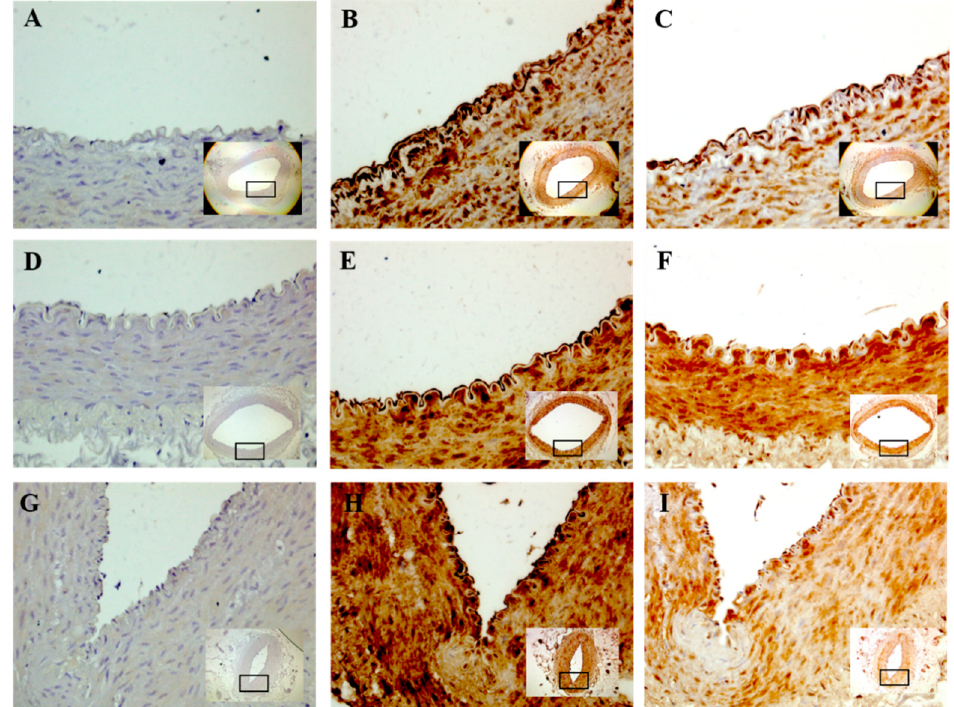
Figure 3. Representative images of immunohistochemistry stained blood vessels; abdominal aorta ( A – C ), iliac ( D – F ), and mesentery ( G – I ) from normal diet fed rabbits. No primary antibody control ( A , D , G ), nitrotyrosine (NT) ( B , E , H ), and endothelial nitric oxide synthase (eNOS) ( C , F , I ) taken at 40× magnification. Inset—image of whole vessel taken at 4× magnification (abdominal aorta) or 10× magnification (iliac and mesentery).